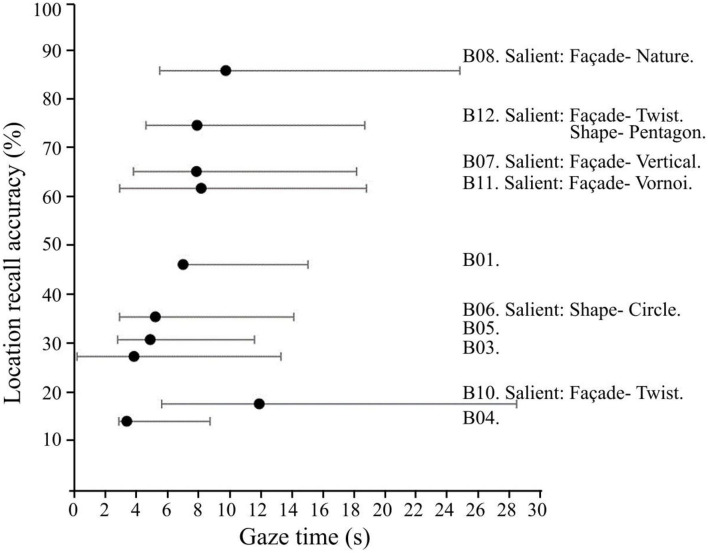
Location recall accuracy compared with gaze time distributions, with error bars showing the 25th and 75th percentile.